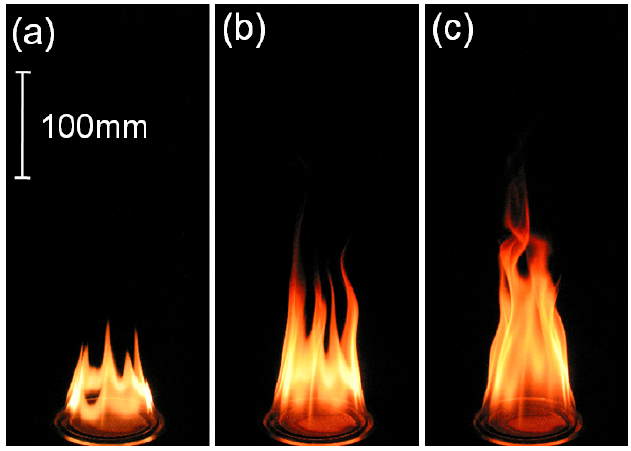
= 19.4 cm/s and 1A